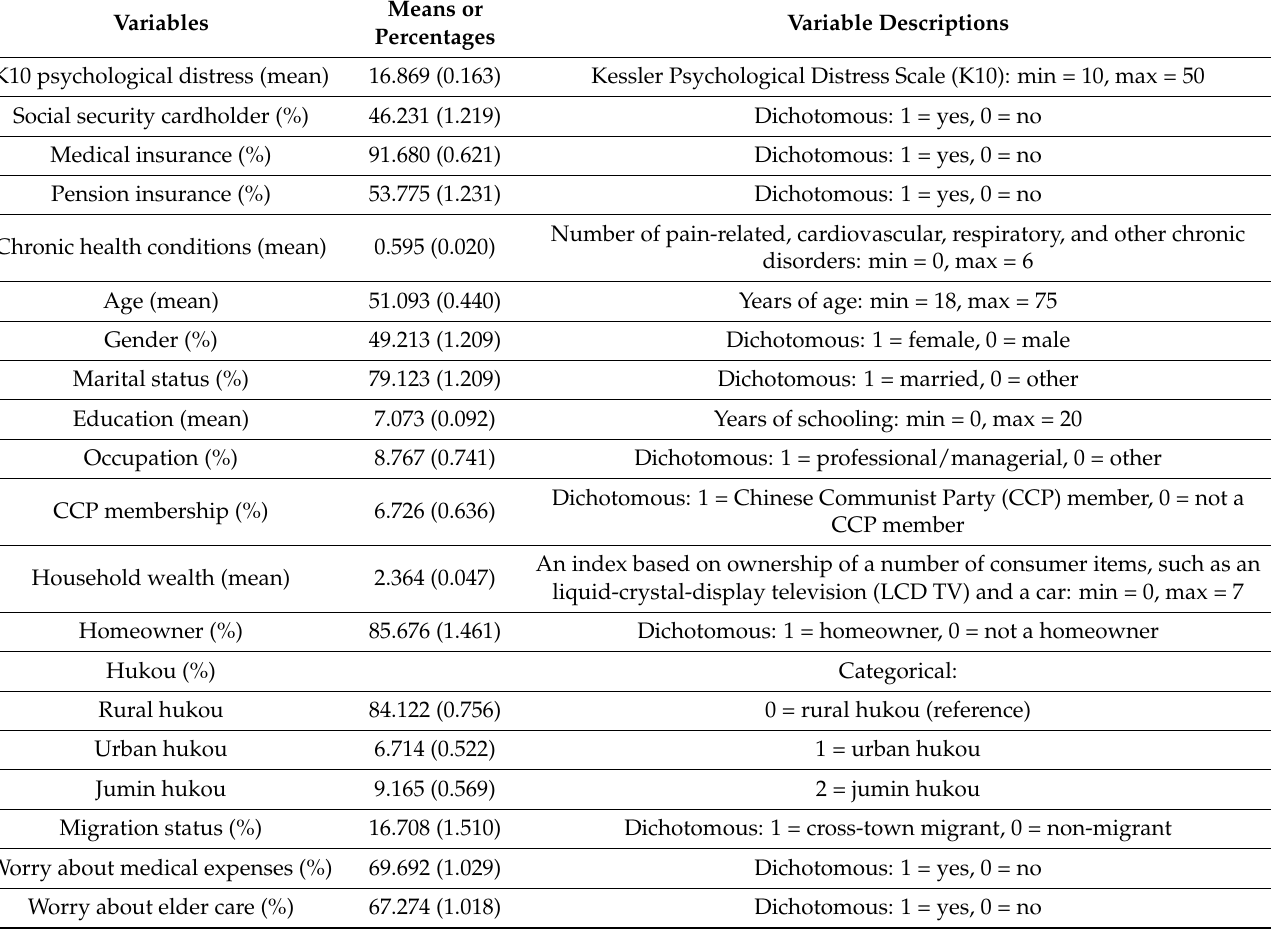
Table 1. Descriptive statistics of survey respondents and variable